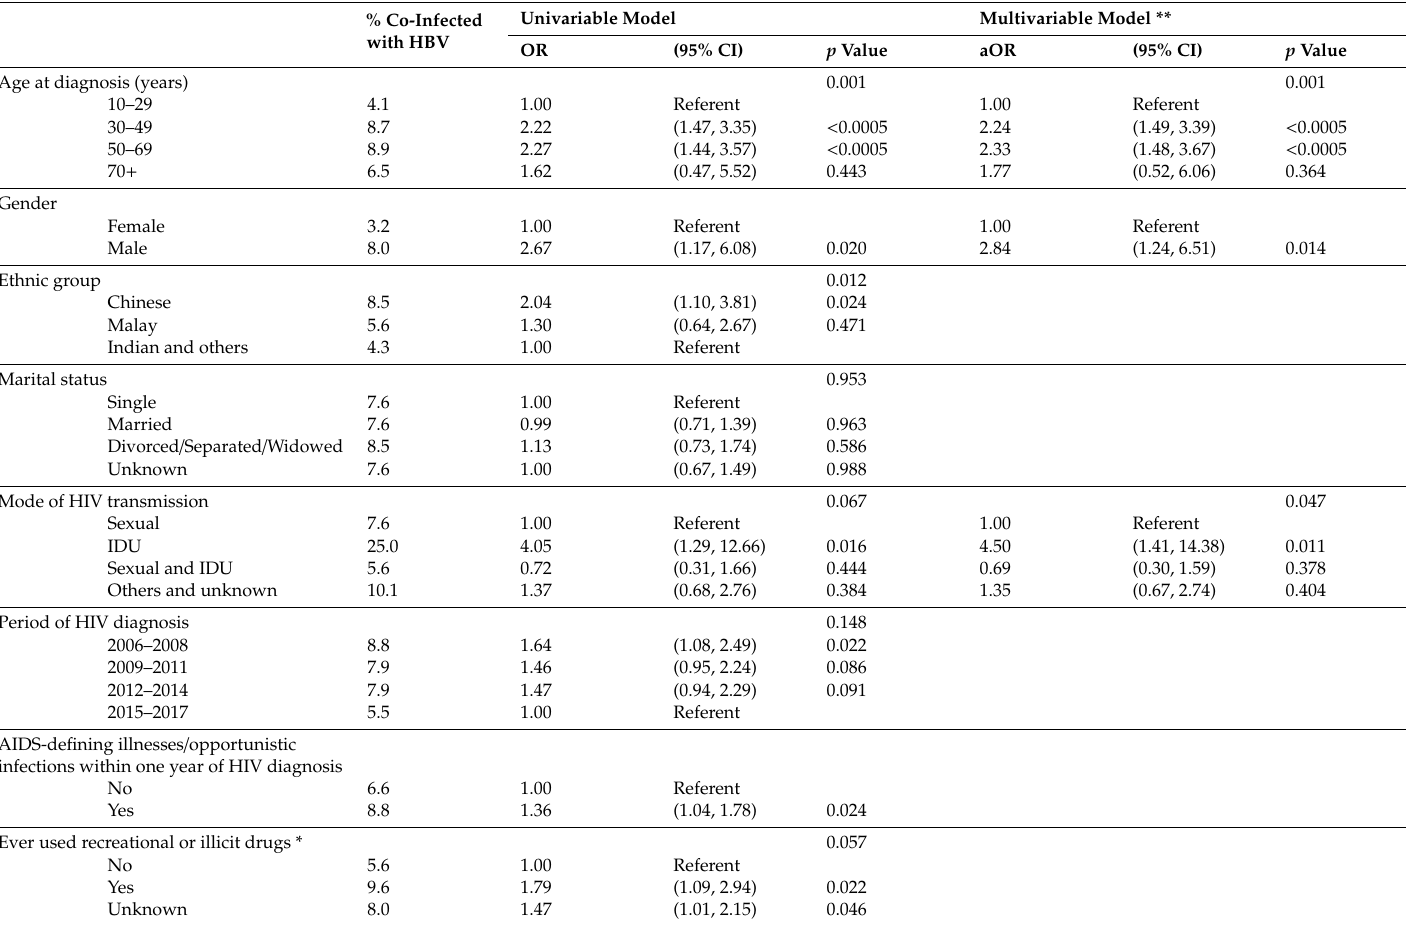
Table 3. Proportion and odds ratios of HBV co-infections in HIV-infected patients who attended the national referral centre for HIV in Singapore, 2006–2017. Univariable Model Multivariable Model % Co-Infected with HBV